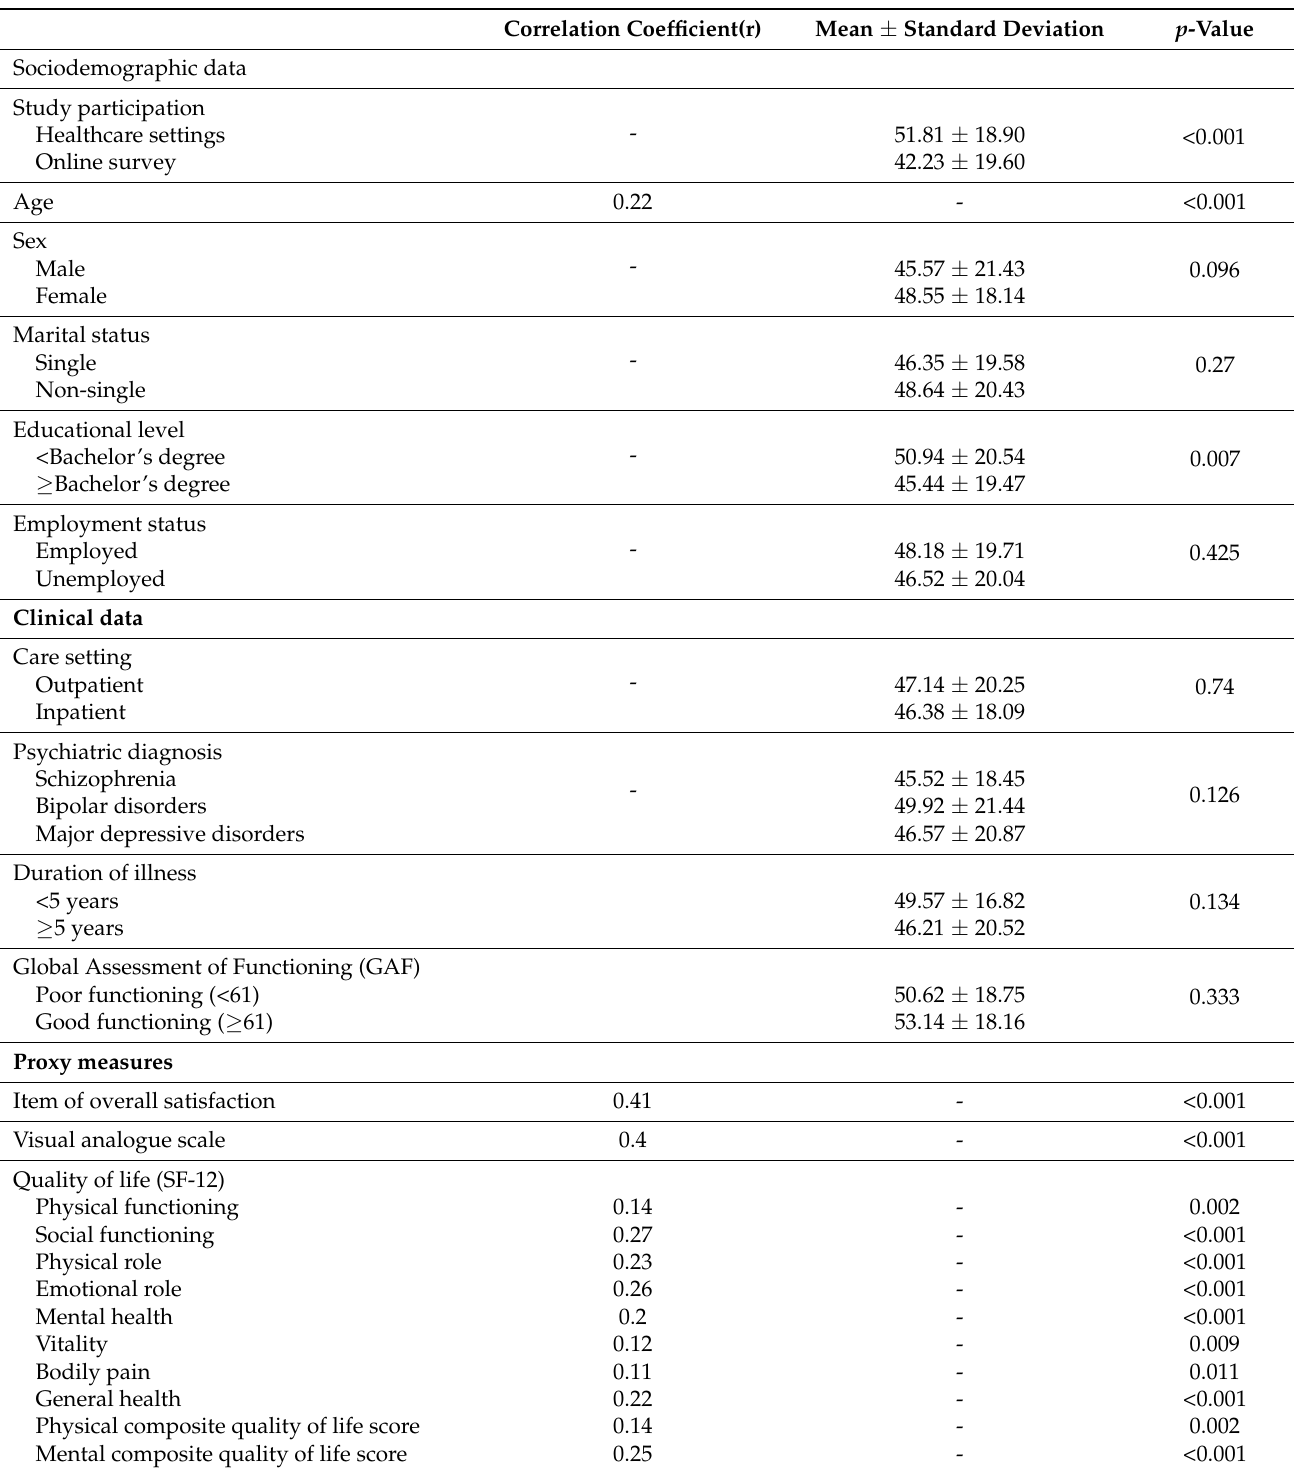
Table 3. External